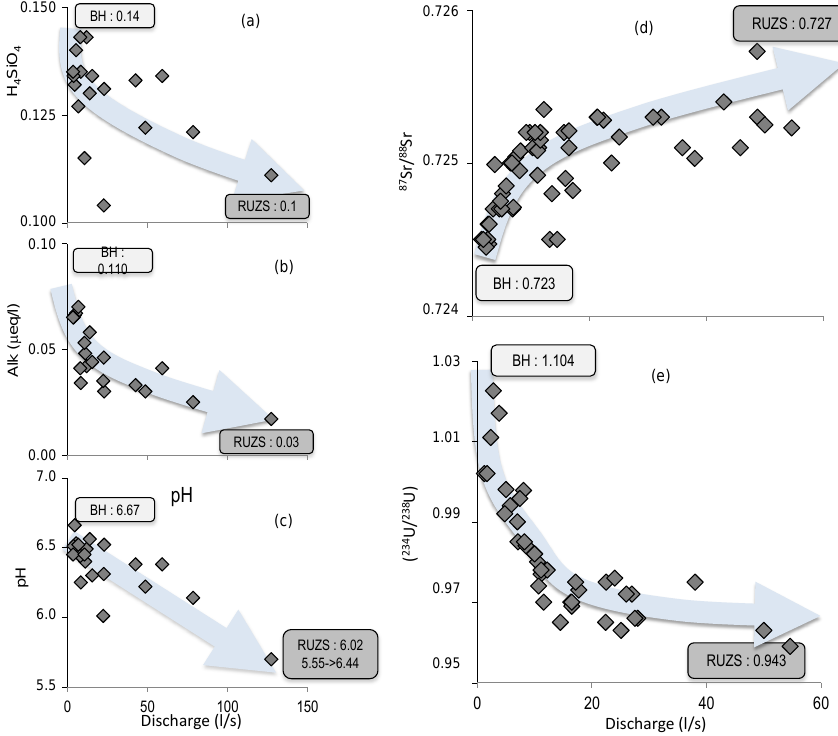
Figure 13. H 4 SiO 4 concentration (a) , alkalinity (b) , pH (c) , ( 234 U / 238 U) AR (d) and 87 Sr / 86 Sr (e) vs. discharge at the outlet for the 2004–2006 period (additional data from Riotte and Chabaux, 1999 and Aubert et al.,